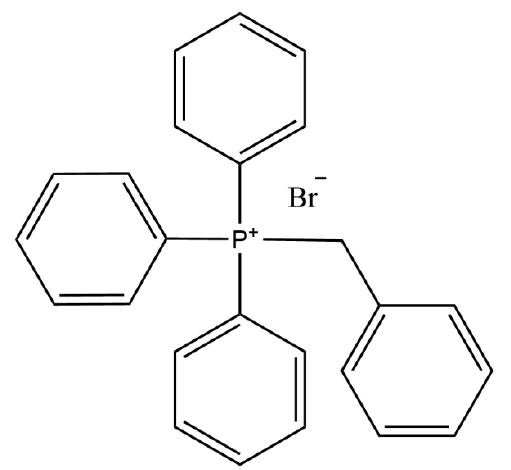
Figure 4. Schematic structure of benzyl triphenyl phosphine bromide.